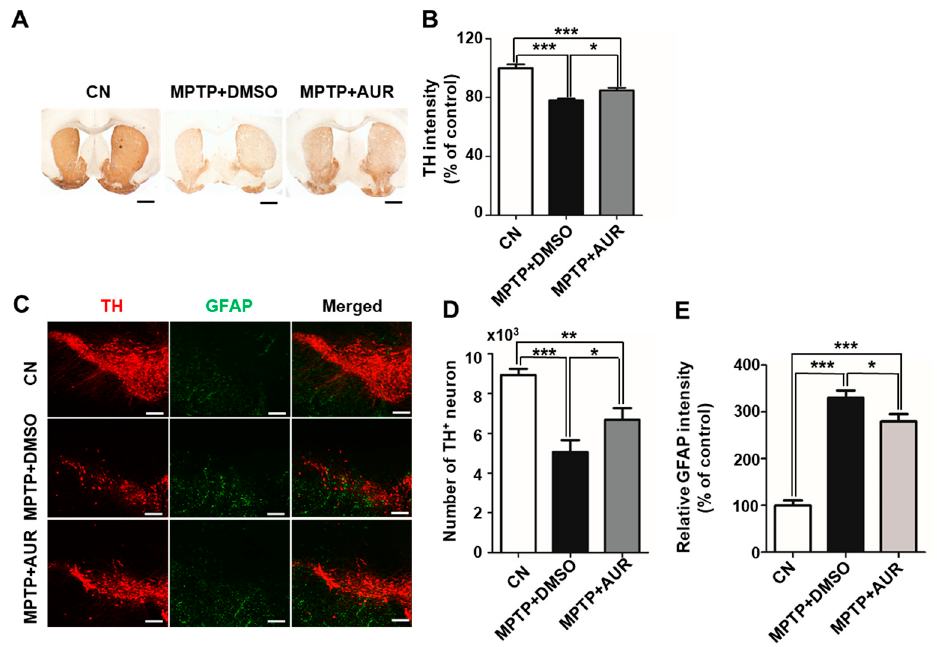
Figure 4. Pretreatment with AUR reduces MPTP-induced loss of TH expression in the SN and striatum. ( A ) Immunohistochemical detection of TH in the striatum of C57BL / 6 mice injected with MPTP (20 mg / kg, i.p.) or saline, together with AUR (25 mg / kg, i.p.) or DMSO. Scale bars: 50 µ m. ( B ) TH expression was decreased in MPTP-injected mice, an e ff ect that was attenuated by AUR cotreatment. TH intensity was measured using ImageJ, and results are presented as a percentage of control values. ( C ) Immunofluorescence detection of TH in the SN region. TH-positive dopaminergic neurons (red) and astrocytes (green) were visualized by confocal microscopy. ( D , E ) Number of TH-positive neurons was calculated, and relative GFAP intensity was measured using ImageJ. Data are presented as means ± SD of three experiments ( n = 10 / group; * P < 0.05, ** P < 0.01, *** P < 0.001 vs. corresponding controls). CN, control. Scale bars: 500 μ m.